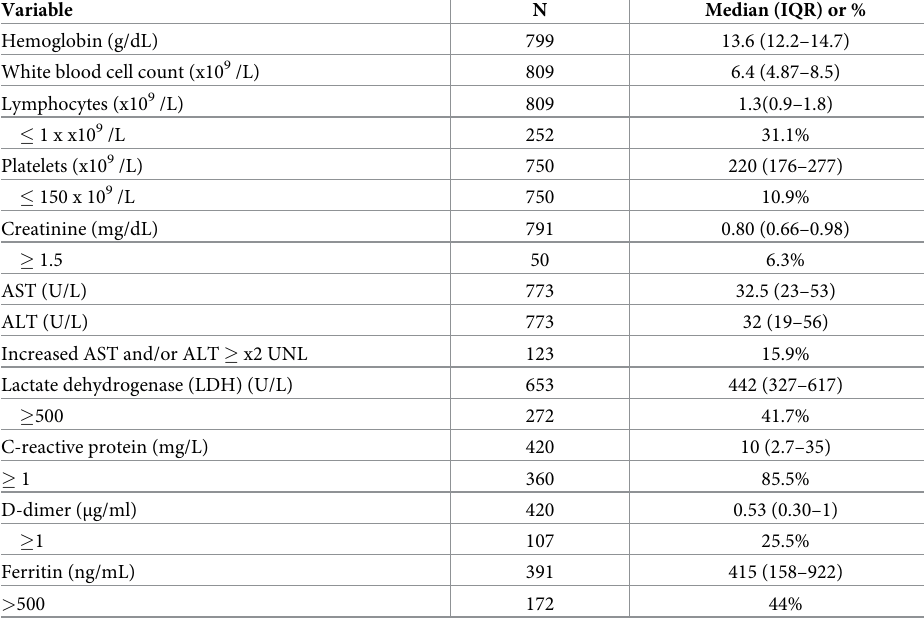
Table 3. Laboratory findings at hospital admission among patients with COVID-19 in